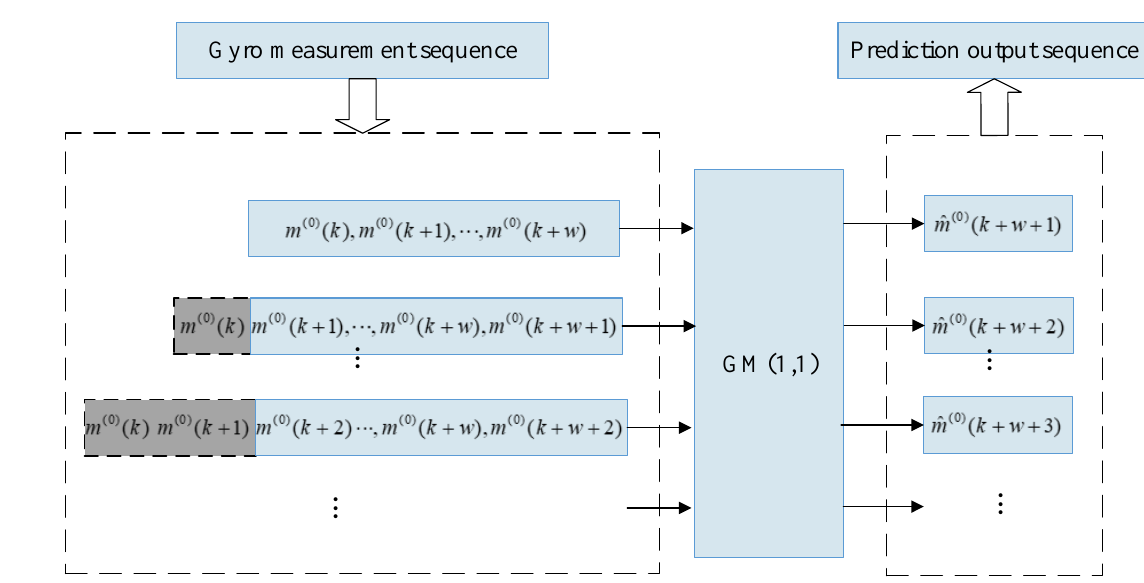
Figure 1. Structure chart of the Gyro’s predictive output based on the metabolism GM(1,1).